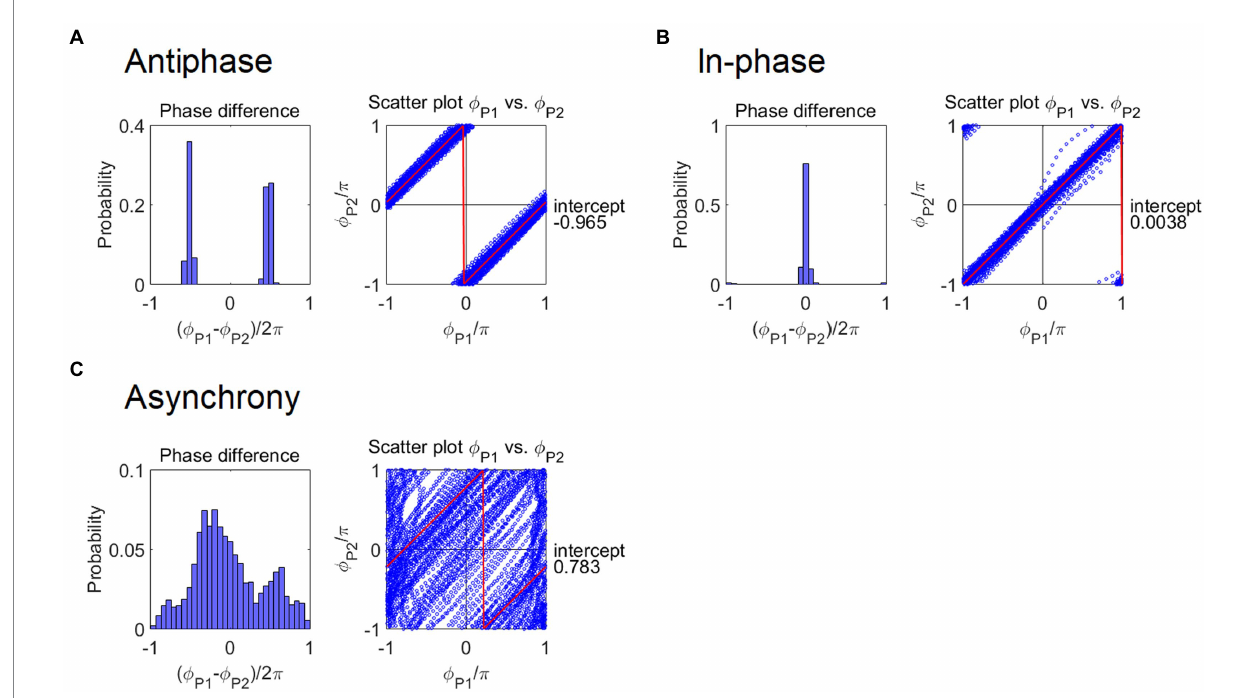
FIGURE 3 Example of a distribution (Left) and a scatter plot (Right) of the phase difference between the handclap motions of the participant (P1) and confederate (P2) in (A) Antiphase, (B) In-phase, and (C) Asynchrony conditions. The distribution of the antiphase condition presented a bimodal peak around −π and π , whereas that in the in-phase condition showed a sharp peak around zero. In the asynchrony condition, the distribution shape was unspecified. In the scatter plot of the phase difference, red lines represent the regression lines fitted with the sawtooth wave function ( ) [ ]. f x The intercept in the plot, f (0), represents the phase difference.